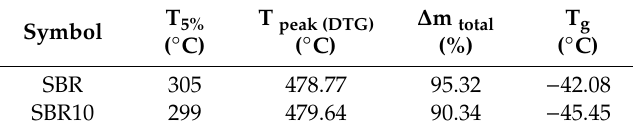
Table 4. Thermal characteristics of SBR and SBR10.